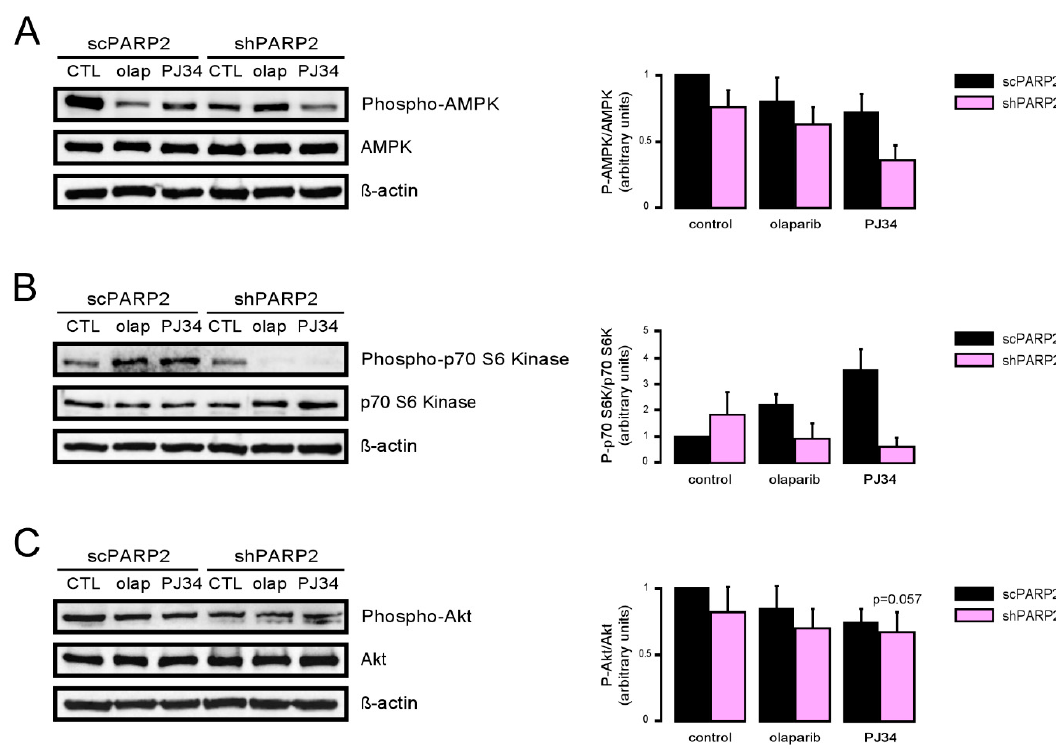
Figure 11. PARP2 enzymatic activity modulates the energy sensors involved in the regulation of autophagy. A total of 200,000 scPARP2 and shPARP2 C2C12 cells were seeded in 6-well plates that were treated with olaparib (olap, 1 µM) and PJ34 (3 µM) for 24 h. Cellular proteins were separated by SDS-PAGE and were blotted and probed with the antibodies indicated on panels ( A – C ). Bands were subjected to densitometry. Experiments were repeated three times; a representative blot is shown.